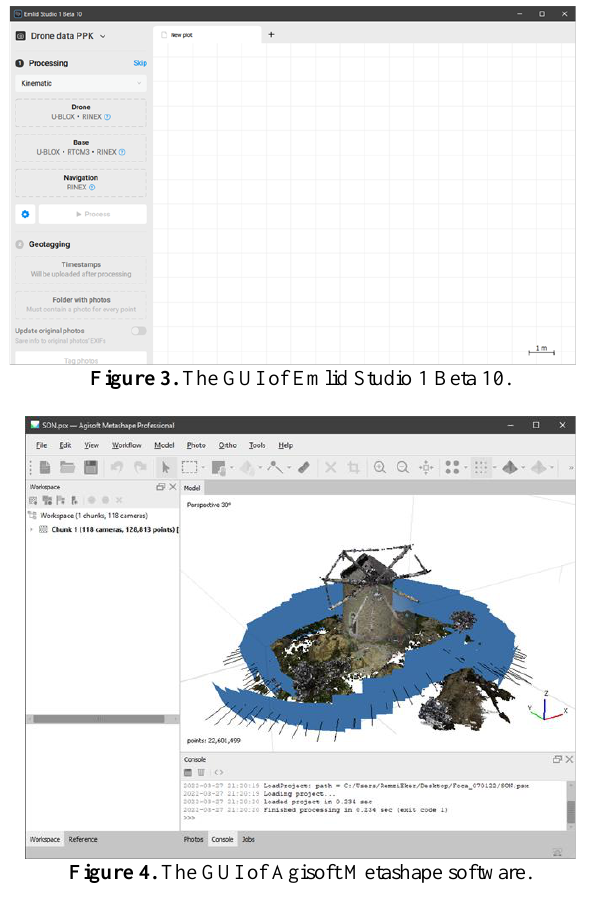
Figure 4. The GUI of Agisoft Metashape software.